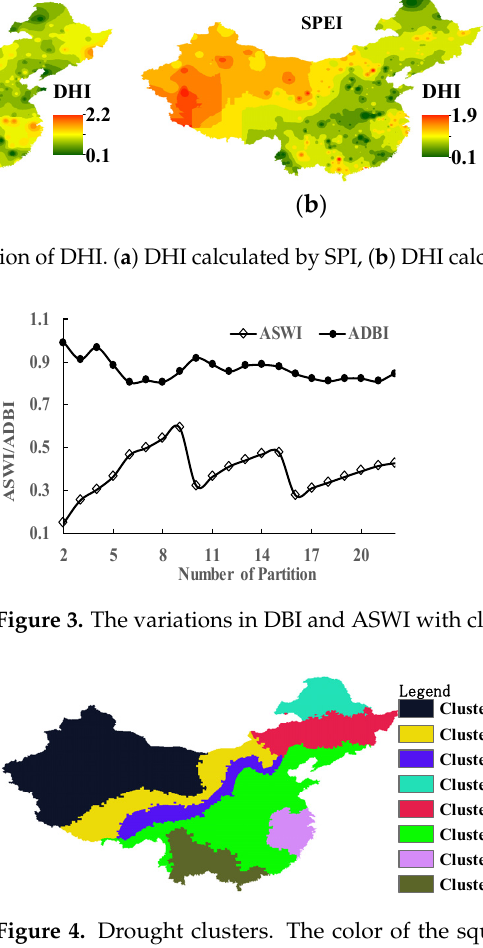
Figure 4. Drought clusters. The color of the squares in the legend represents the serial number of clusters.